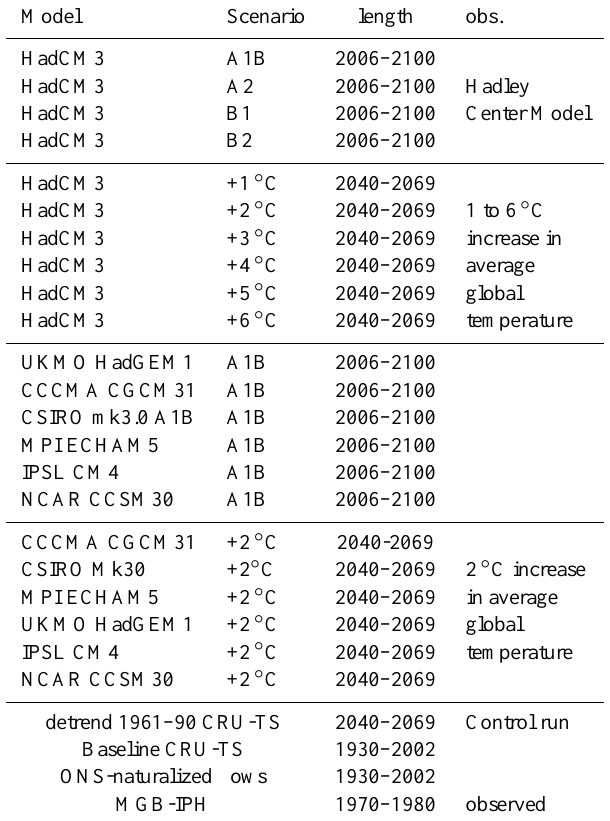
Table 2. Hydrological model runs.